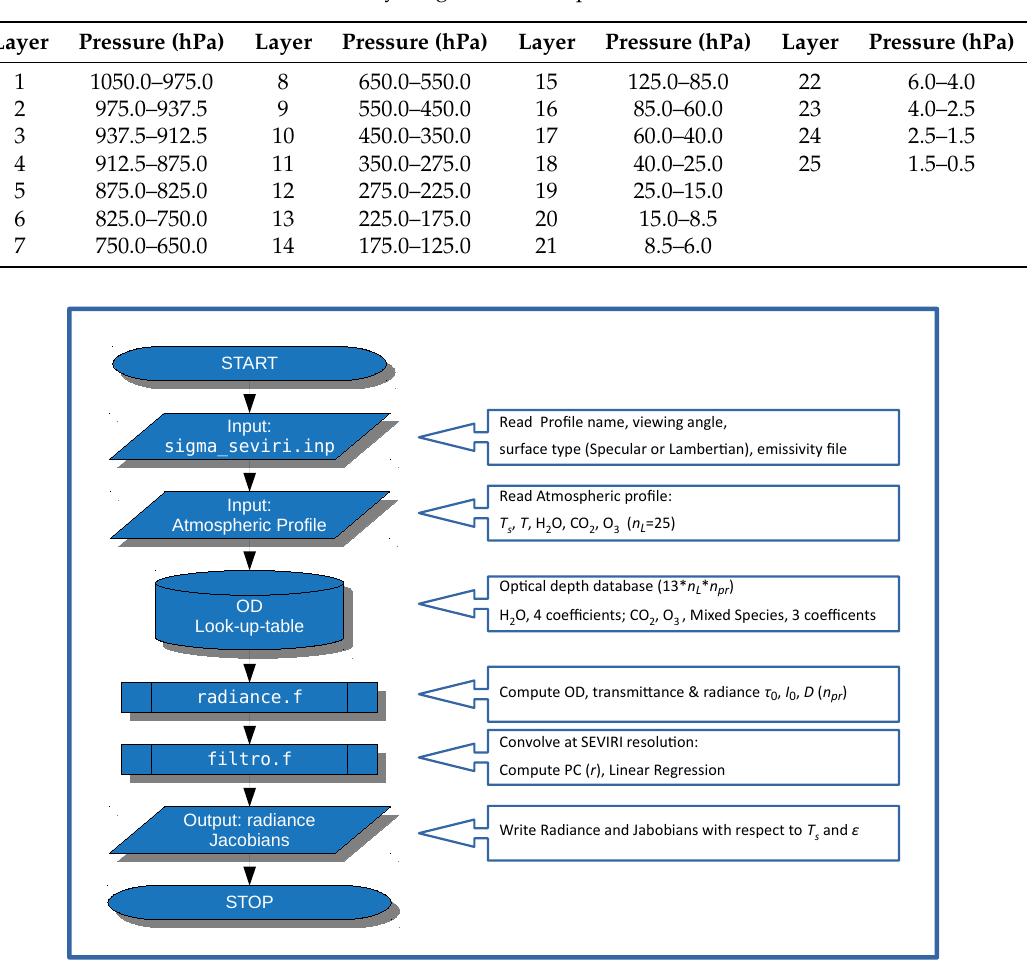
Table 3. Pressure layering of the atmosphere used in σ -SEVIRI.